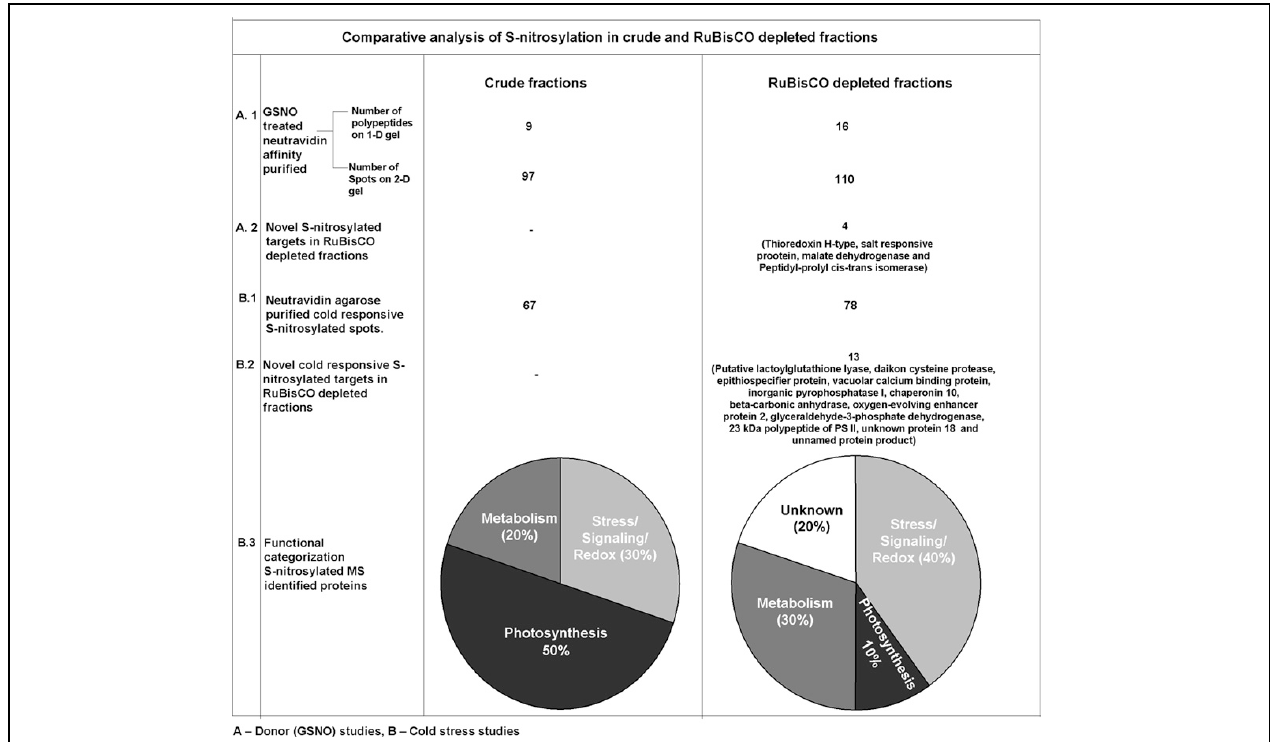
FIGURE 6 | Comparison of S-nitrosylation in crude and RuBisCO depleted fractions showing increased S-nitrosoproteome coverage by RuBisCO depletion.